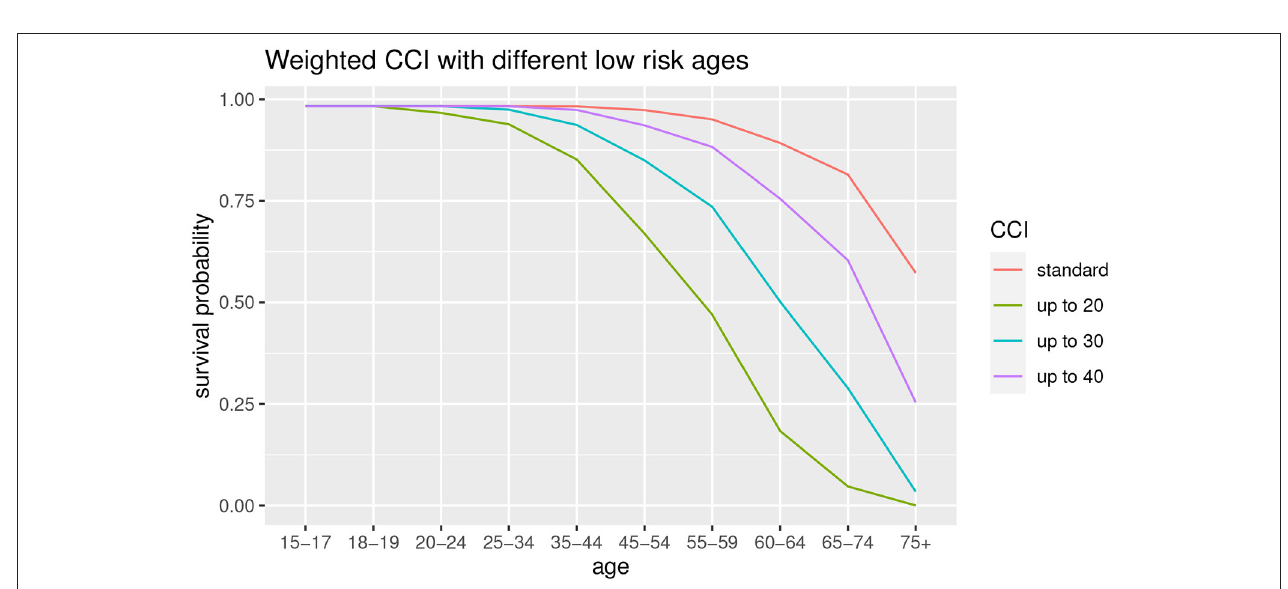
FIGURE 6 | Survival probability with different age